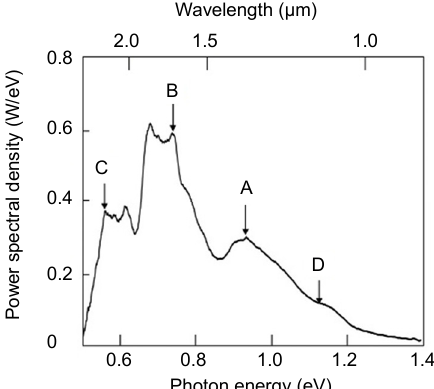
Fig. 4 | Light emission spectra of the Si-LED. The substrate tem- perature and the injection current were 283 K and 2.45 A, respec- tively. Downward arrows A–D represent the spectral peaks